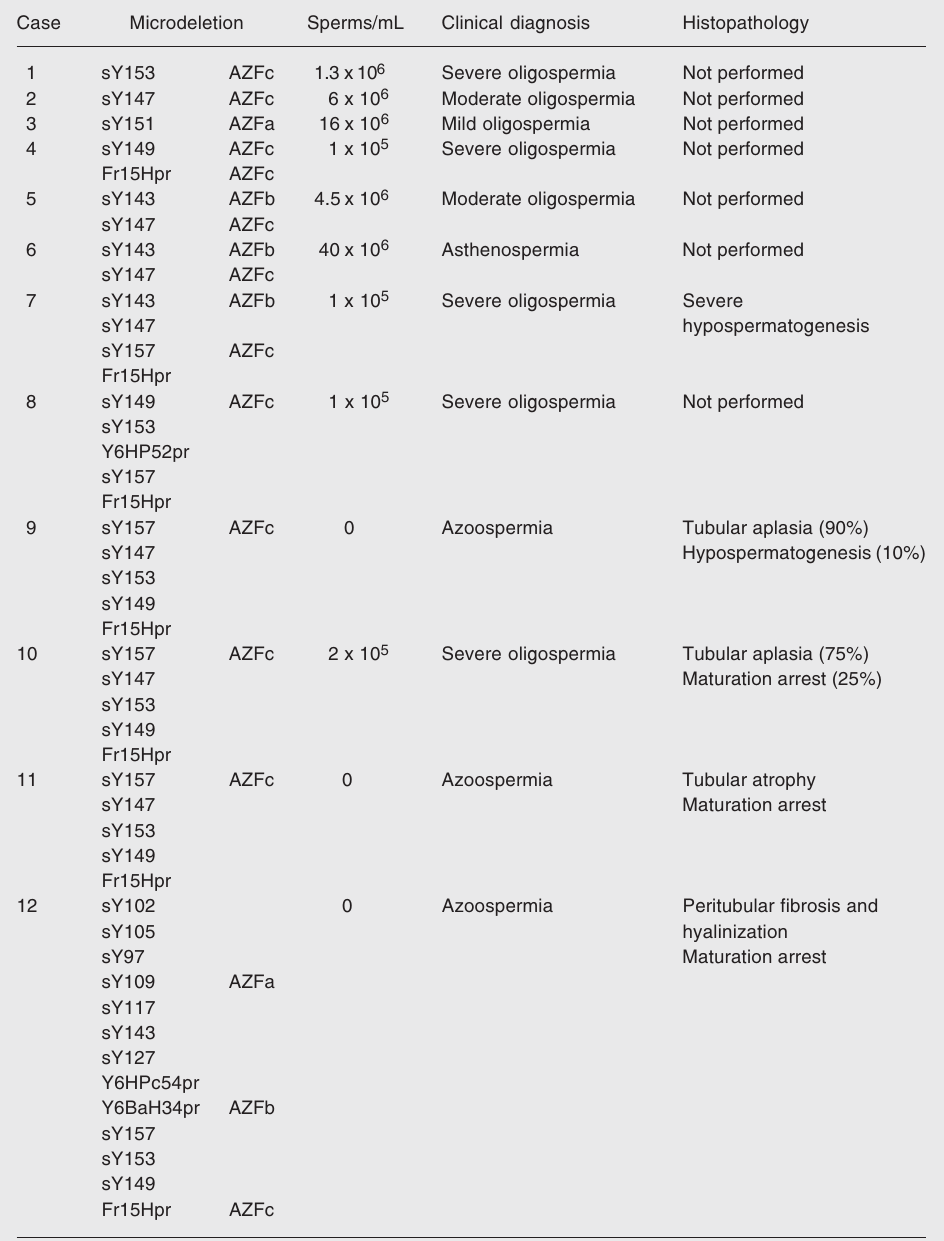
Table 1. Genotype-phenotype association in azoospermia factor gene (AZF)